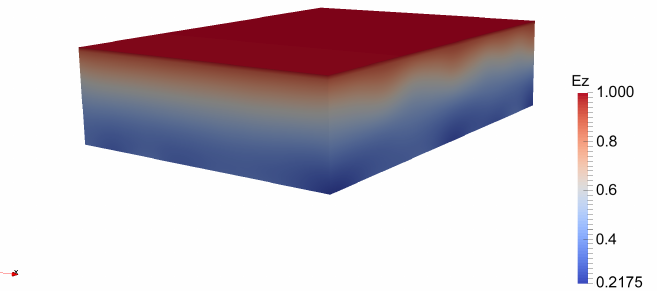
Figure 12. Simulated electric field when the incident field is polarized in the direction of the fibers for ω 1 = 2.45